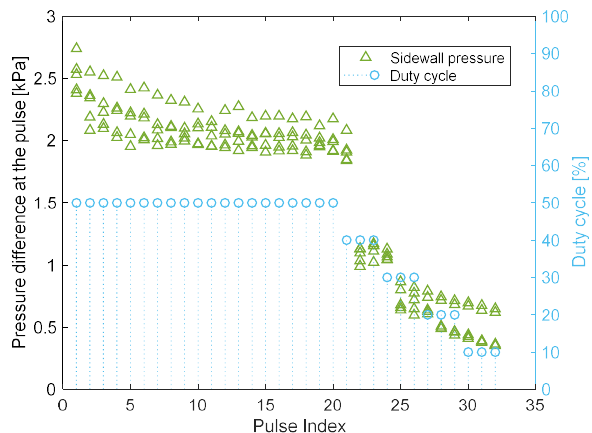
Figure 11. Maximum pressure difference at each pulse, for five measurements of 200 mg .